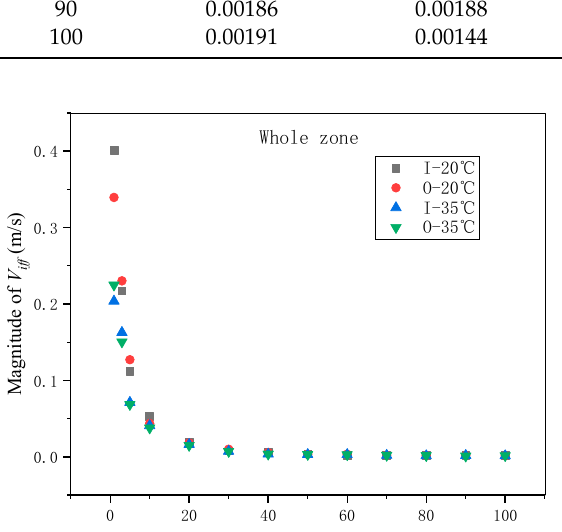
V at different positions in the in- iff